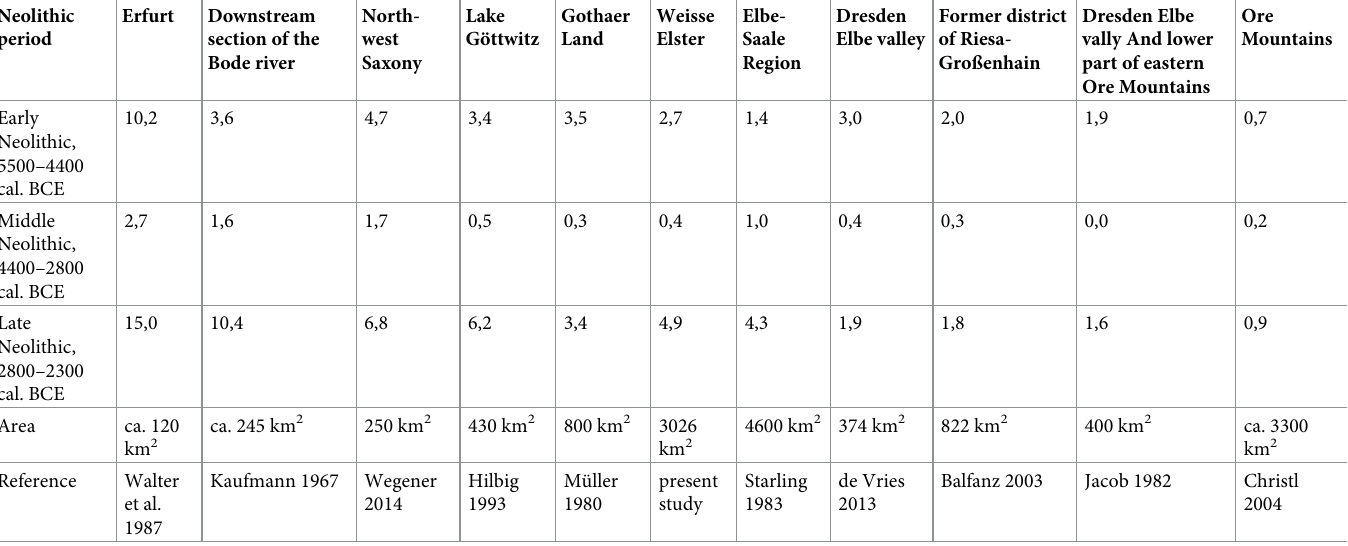
Table 3. Average Neolithic site frequencies per 250 km 2 in the study area and adjacent